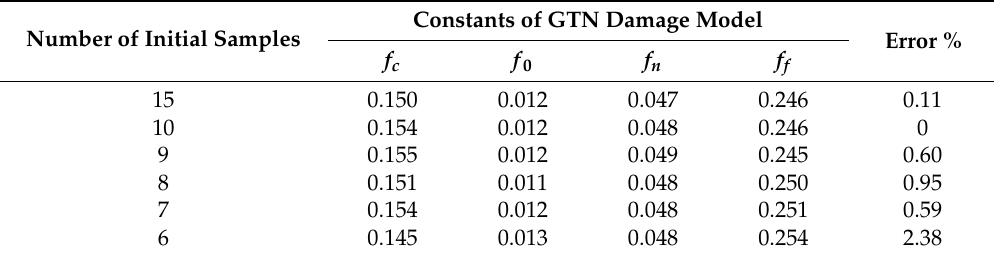
Table 3. The results of Kriging method with different numbers of initial samples.